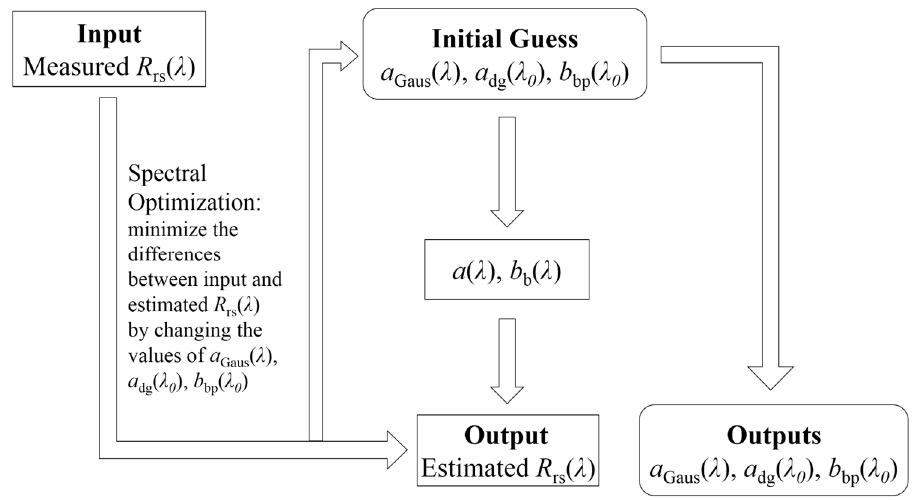
Figure 2. Flowchart of the inversion method. Utilizing satellite or in situ measured remote sensing